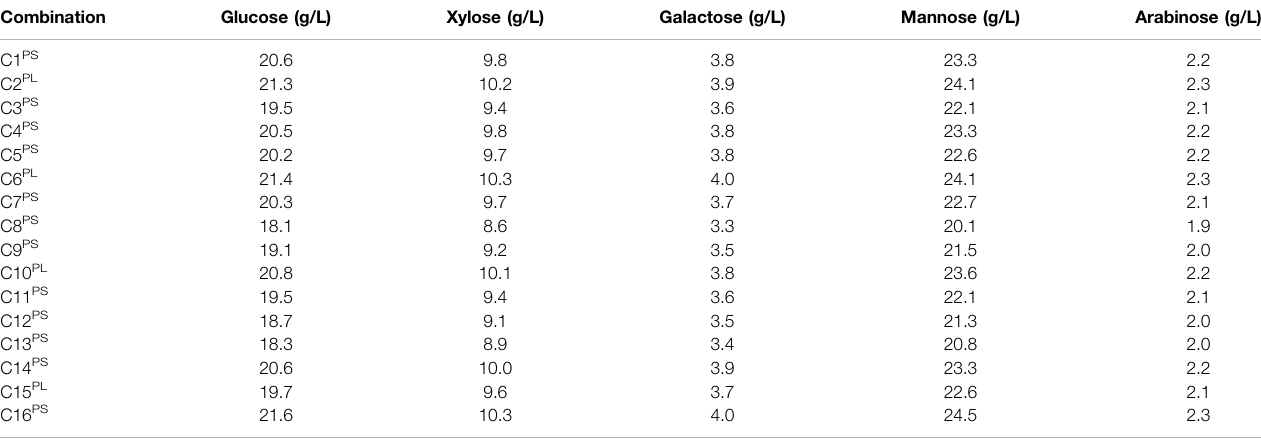
TABLE 5 | Concentration of monosaccharides in the pretreated slurry (PS) and hydrolysate (PL) with and without addition of sodium dithionite, sodium sul fi te, sodium borohydride, calcium hydroxide, activated charcoal, and hydrogenation. a Combination Glucose